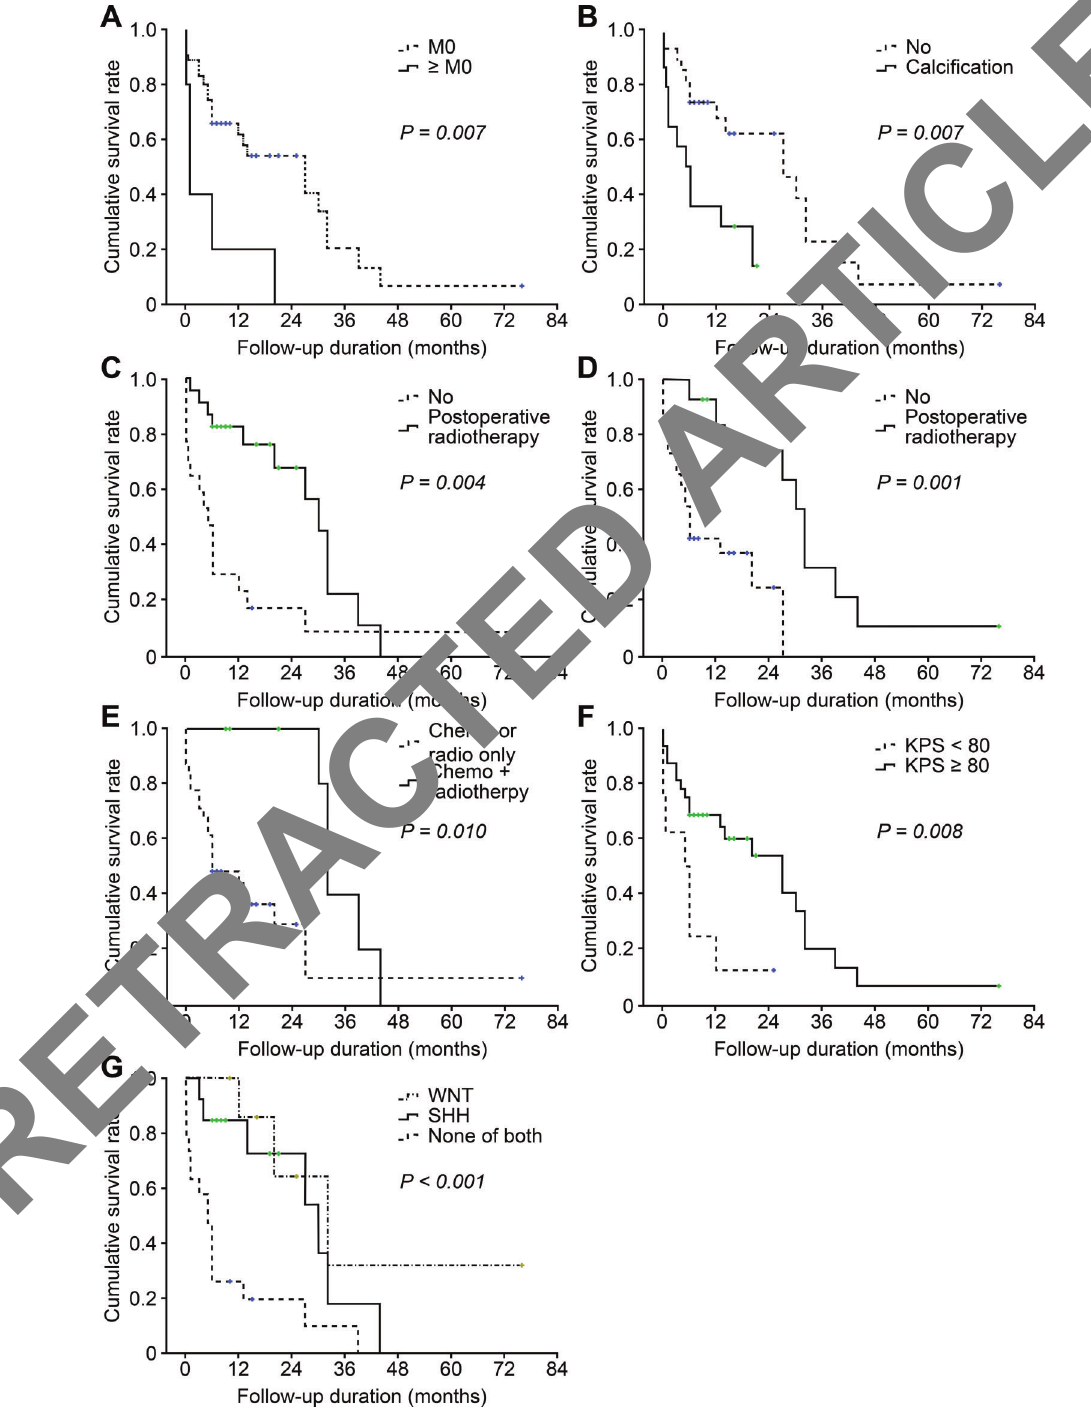
Figure 1 - Kaplan-Meier curves of overall survival according to (A) M stage, (B) calcification, (C) postoperative radiotherapy, (D) postoperative chemotherapy, (E) postoperative adjuvant therapy, (F) postoperative KPS score, and (G) molecular subtype. A log-rank test was performed to test the survival status between